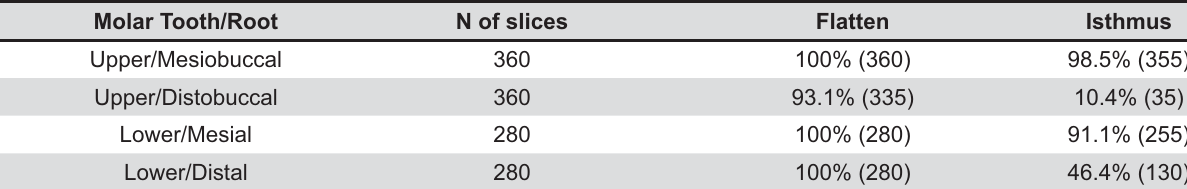
Table 2- Molar Tooth/Root N of slices Flatten Upper/Mesiobuccal